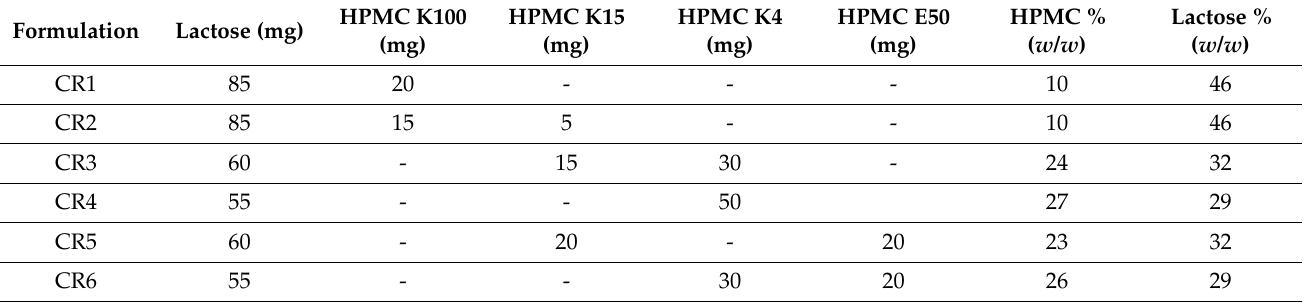
Table 1. Composition of each tablet in controlled-release formulations (CR1–CR6). Hypermellose was obtained from the Dow Chemical Company as METHOCELL K100 Premium CR, K15M Premium CR, K4M Premium CR, and E50 Premium.